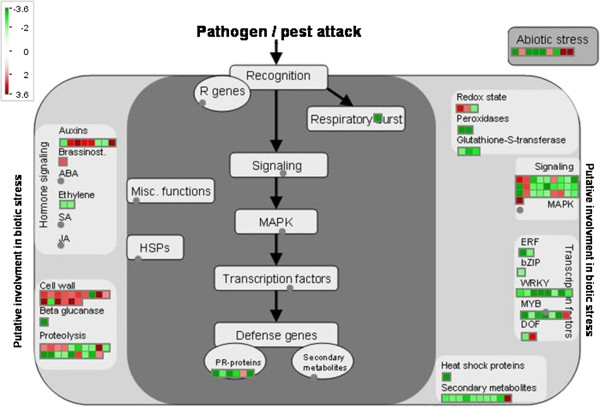
Expression of genes involving in stress responses. We mapped the differentially expressed genes identified as being involved in stress responses, and their expression ratios, onto different stress response pathways, as indicated. The ratios in the biological replicates were averaged, converted to a log2 scale, and imported into MapMan, which converts the data values to a false color scale. Transcripts called not present are shown as gray, transcripts that increased in plants with high photosynthetic efficiency are shown in red, and transcripts that decreased are green.